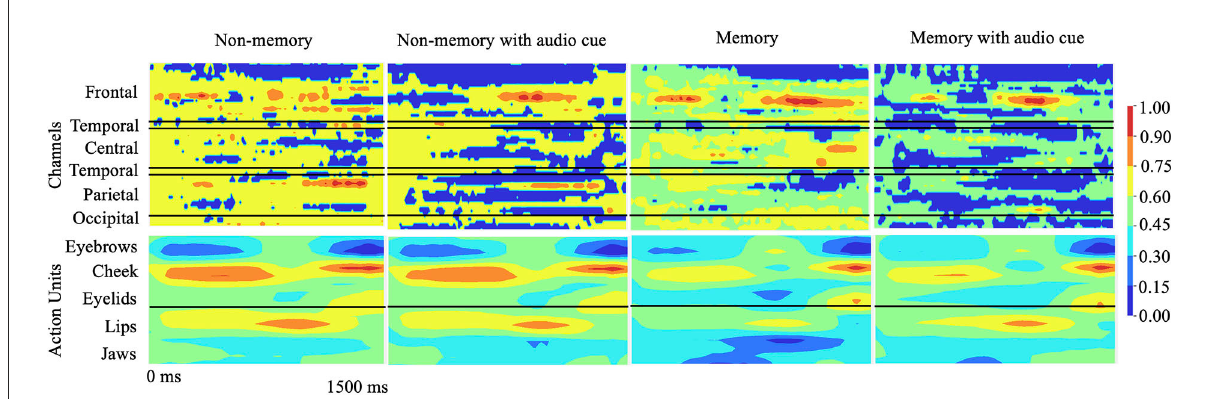
FIGURE3 Qualitative results: 2D explanation-map-pairs generated for different cognitive experiments for multimodal inputs (AU and EEG) using the proposed multimodal DeepSHAP algorithm (normalized) are illustrated. Spatio-temporal impact of EEG or face AU toward disfluency can be understood using this temporal map-pair. The red region shows the highest impact toward stuttering prediction while the blue region shows the least